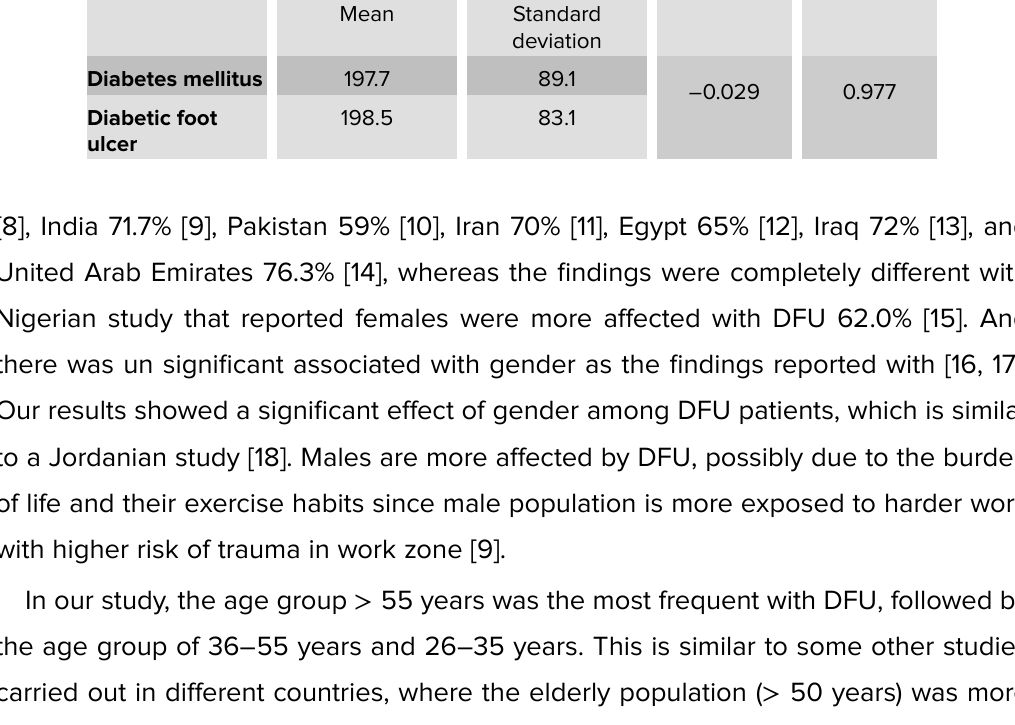
TABLE 3: The difference between fasting blood glucose level in diabetic and diabetic foot ulcers patients Category Fasting blood glucose levels